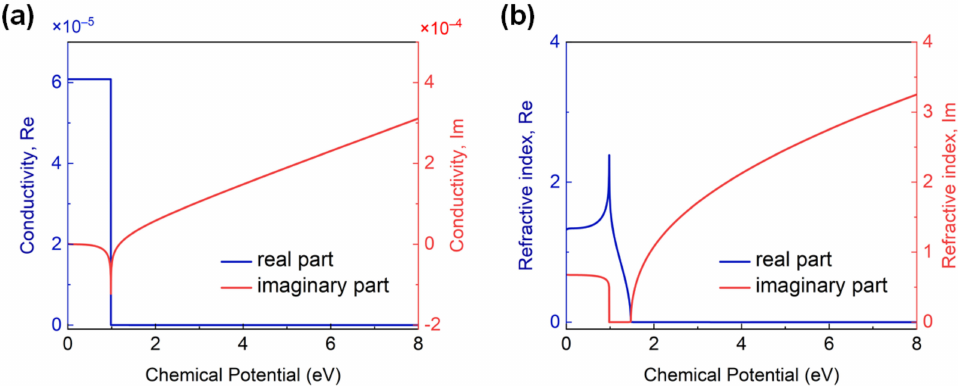
Figure 5. ( a ) Chemical potential (eV) versus conductivity and ( b ) chemical potential (eV) versus refractive index for three-layer graphene.